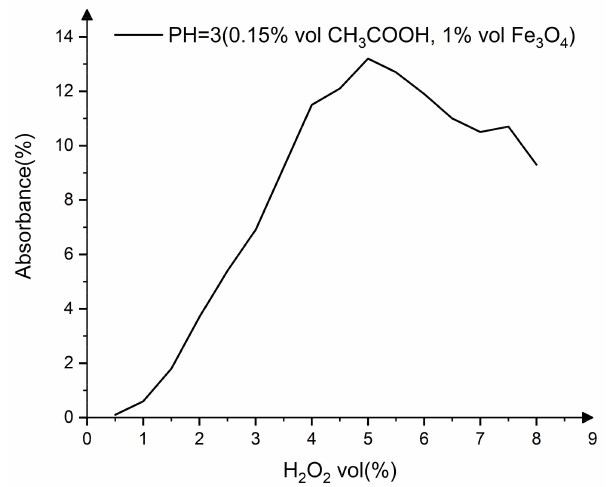
Figure 3. Effect of H 2 O 2 concentration on absorbance.